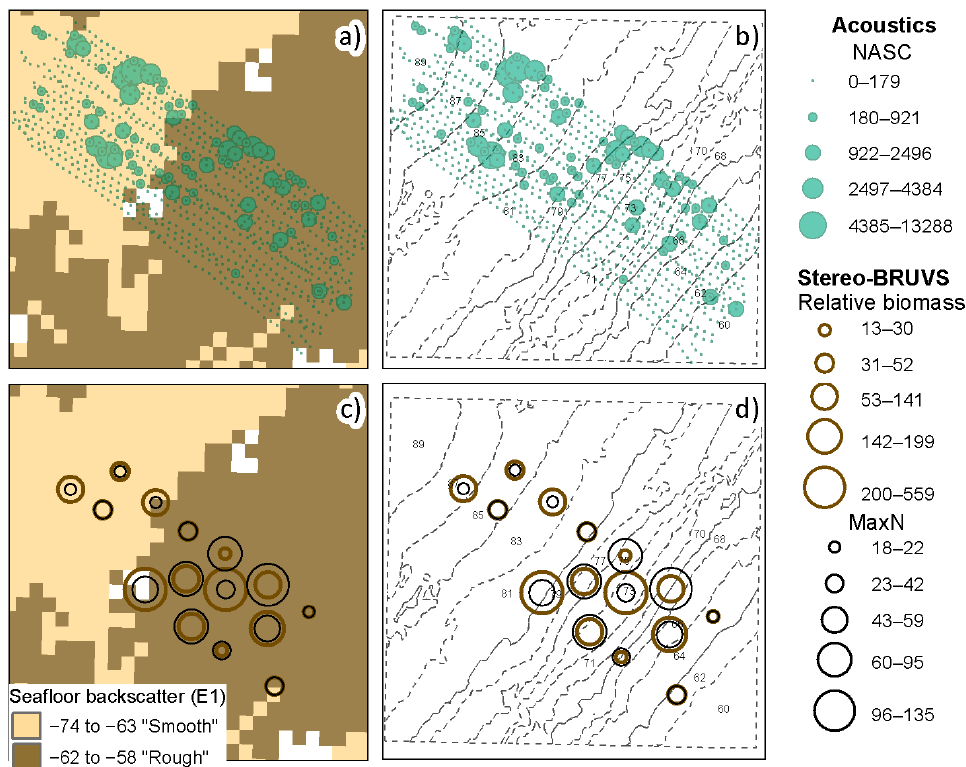
Figure 7. ( a ) Depth-stratified acoustic NASC shown as graduated circles laid over the acoustic classification of the seafloor. ( b ) Depth-stratified acoustic NASC shown as graduated circles with isobaths shown in the background. ( c ) Relative biomass and abundance (MaxN) from the stereo- BRUVs shown as graduated circles laid over the acoustic classification of the seafloor. ( d ) Relative biomass and abundance (MaxN) from the stereo-BRUVs shown as graduated circles with the isobaths shown as discontinuous lines.